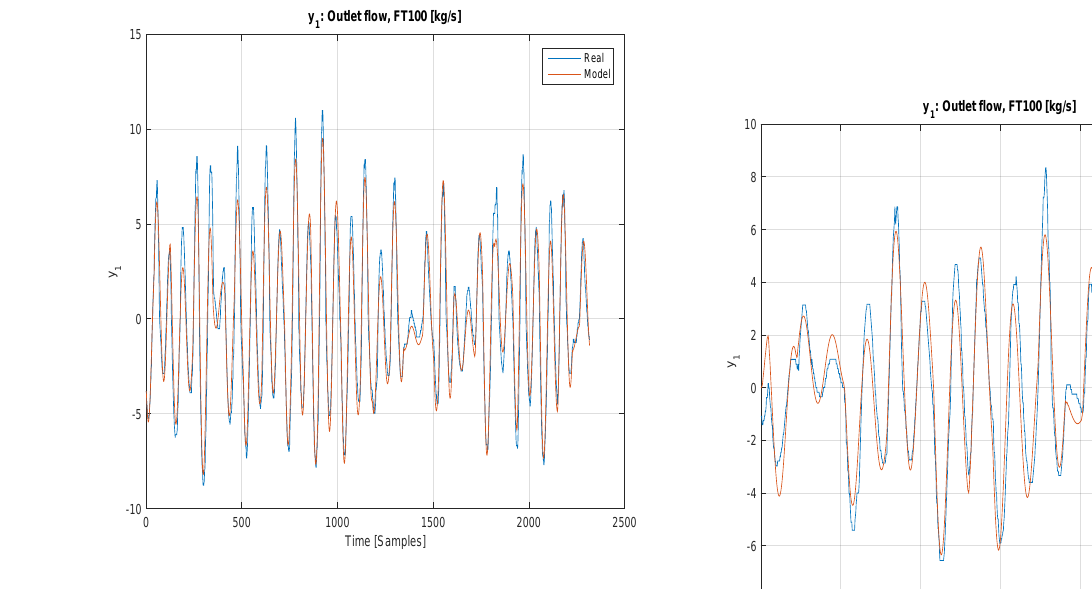
Figure 7: Model ( L = 7 , J = 12 , n = 5) simulated and compared to the identification set, giving MSE = 1 . 0777. Results from a MATLAB script associated with Fig. 3. Case A Figure 8: Model ( L = 7 , J = 12 , n = 5) simulated